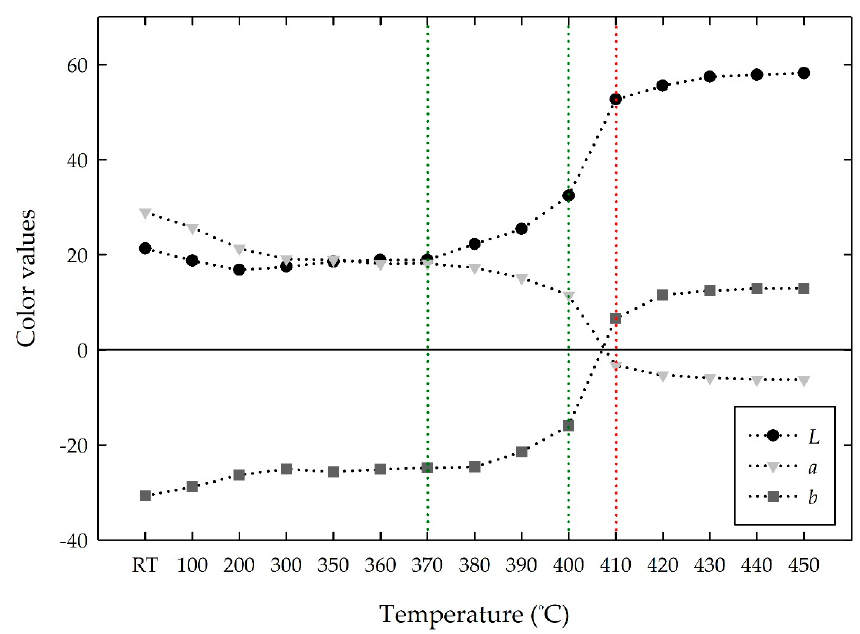
Figure 3. Changes in the Lab values of the MV pigment with increasing temperature.